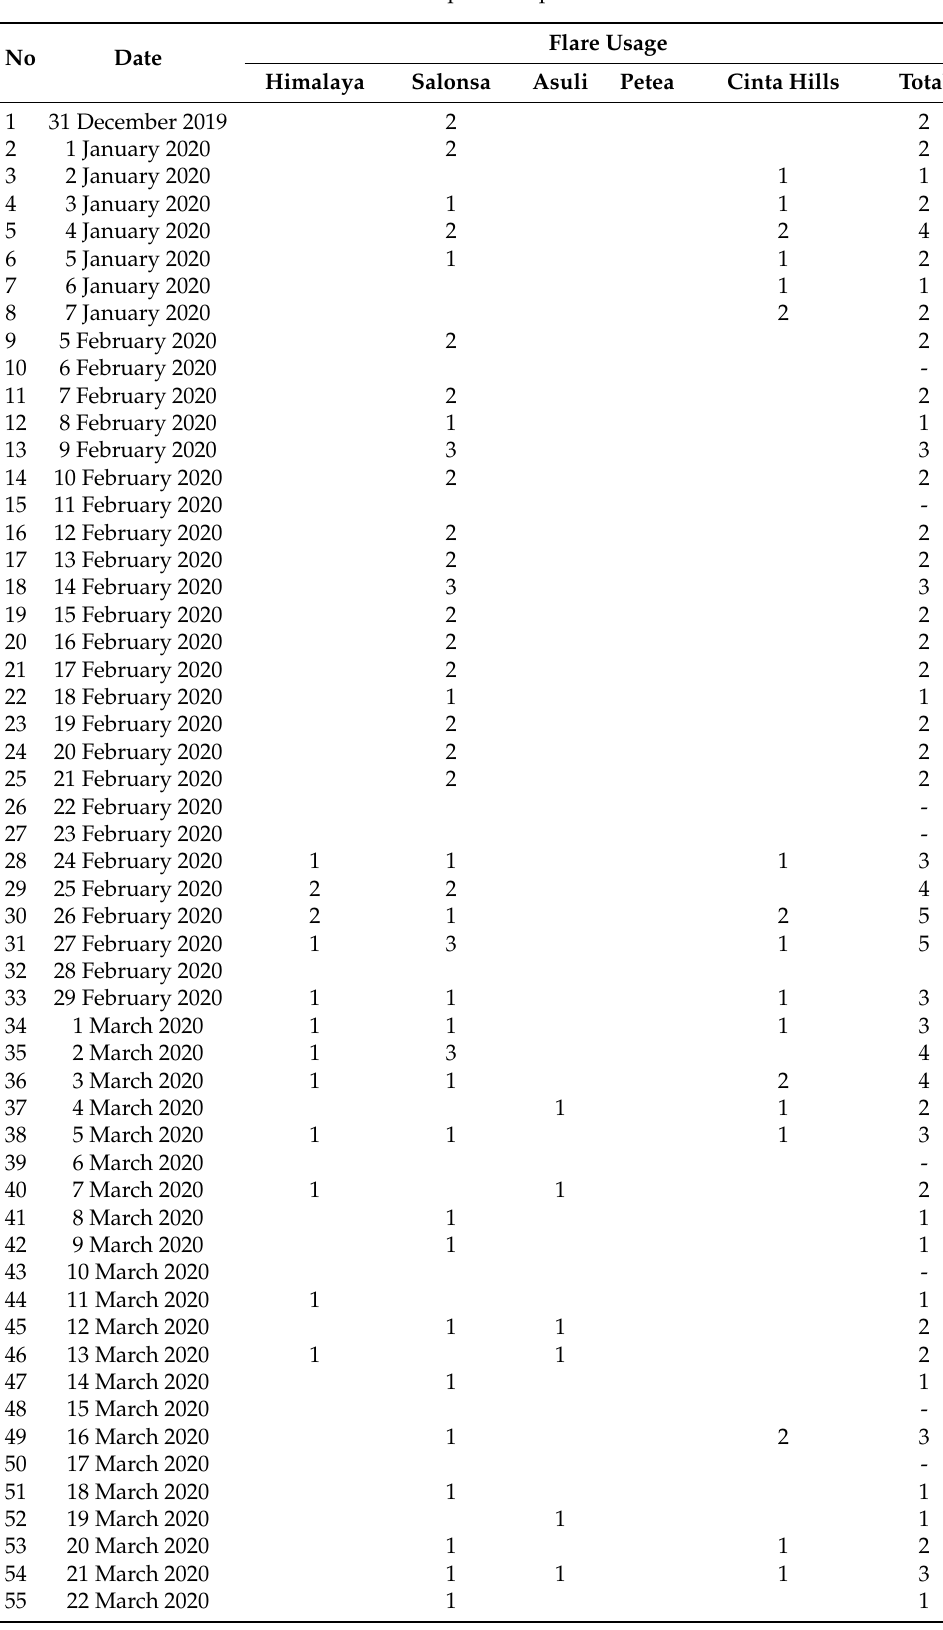
Table A1. Day by day flare usage for five GBG towers during the 2020 weather modification